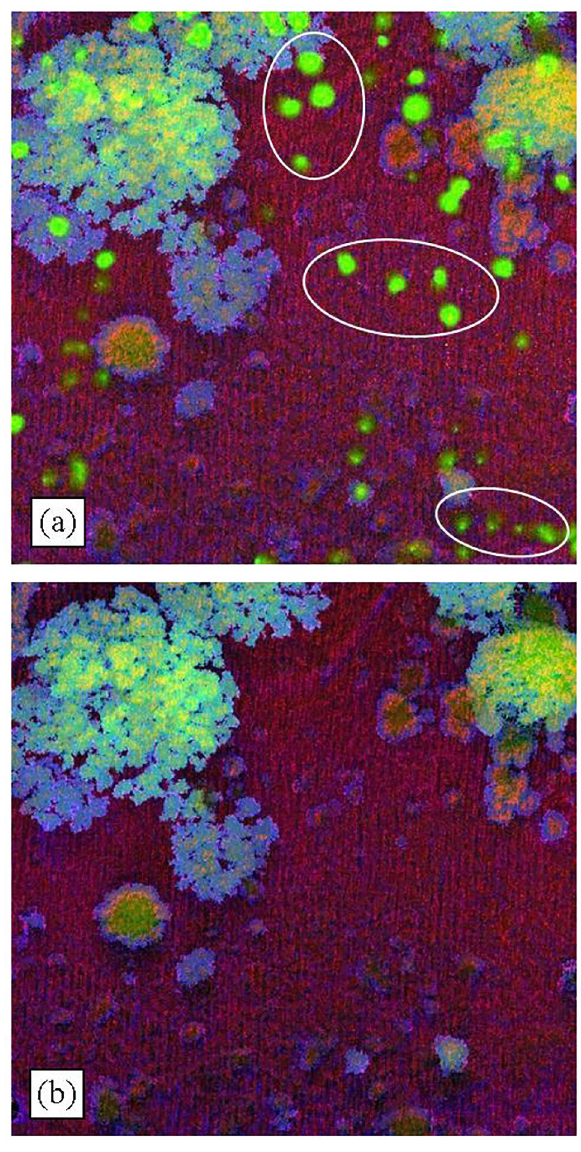
Fig. 5 Pre-processed point cloud (colourised as per elevation), and false colour composite (kurtosis, maximum vegetation height and coefficient of variation) of LiDAR matrices for a subset area: a With- out pre-processing and b With